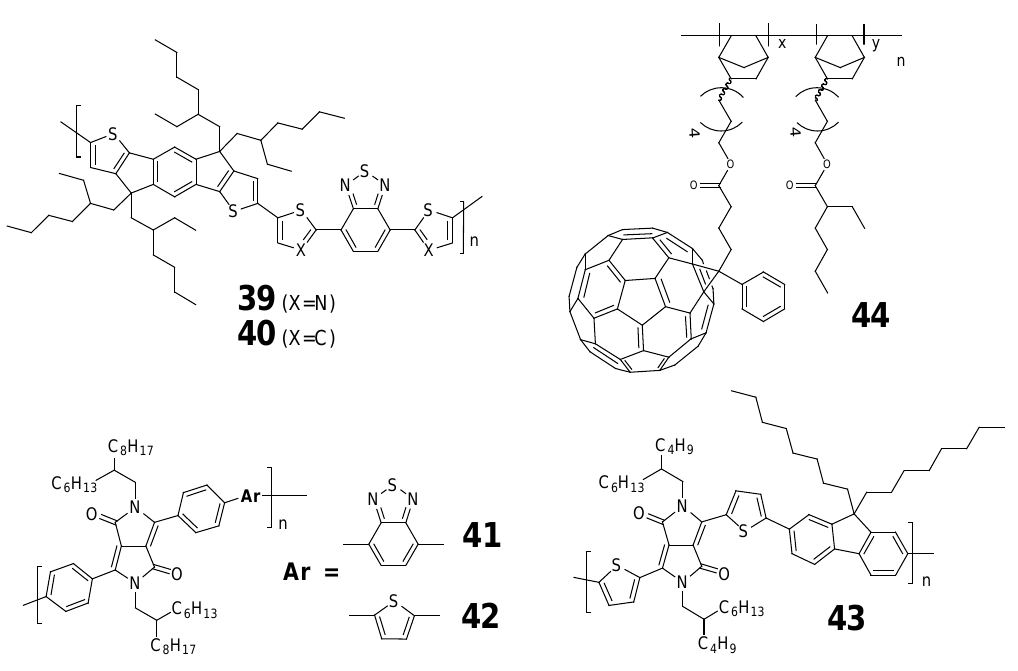
Figure 9. Molecular structures of polymer acceptors containing electron-withdrawing units ( 39 – 44